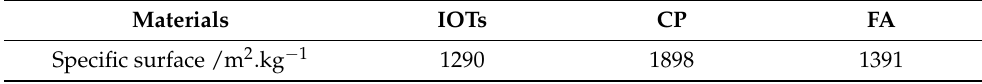
Figure 1. SEM image of ( a ) IOTs; ( b ) CP; and ( c ) FA. Table 2. The specific surface area of the materials.